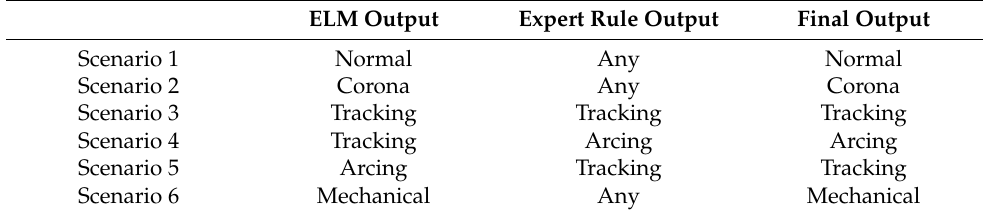
Table 18. Final output from the Ultrasound Analyzer System for a